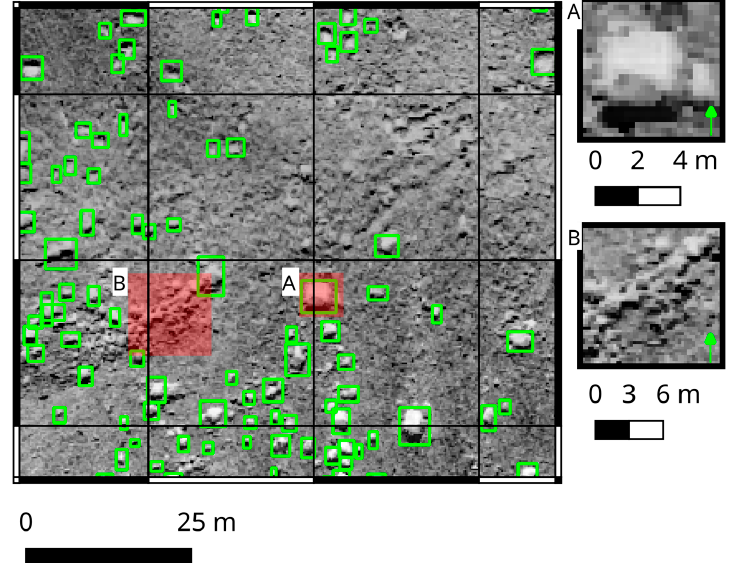
Figure 2. Examples of boulder bounding boxes manually interpreted from the training mosaic. Ideally, stones are characterized by a high backscatter front facing the sidescan-sonar, an intermediate backscatter top, and an adjacent acoustic shadow ( A ). In several cases, densely packed boulders ( B ) could not be individually digitized and have not been included in the training dataset. Arrows indicate the direction of insonification in A and B. Several cobbles or small boulders (upper right) have been missed during mosaic screening. All training boundary boxes are available as Supplementary Material S3.